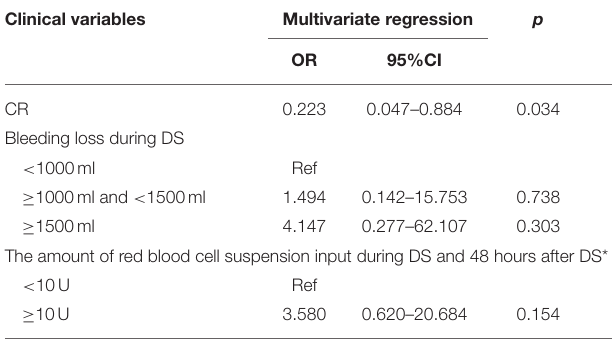
TABLE 7 | Multivariate logistic regression analysis of the risk factors for recurrent fistula before PSM. Clinical variables